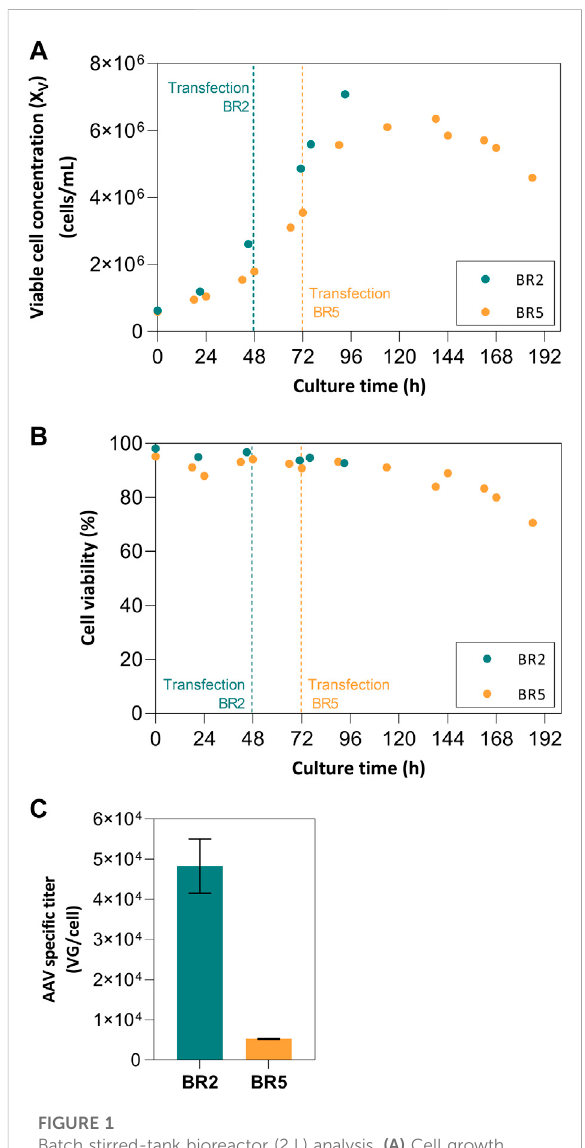
FIGURE 1 Batch stirred-tank bioreactor (2 L) analysis. (A) Cell growth pro fi les for batch runs with VCC TOT of 2 × 10 6 cells/mL (BR2) and VCC TOT of 5 × 10 6 cells/mL (BR5); (B) Viability pro fi les for bioreactor batch runs BR2 and BR5; (C) Speci fi c titers for each